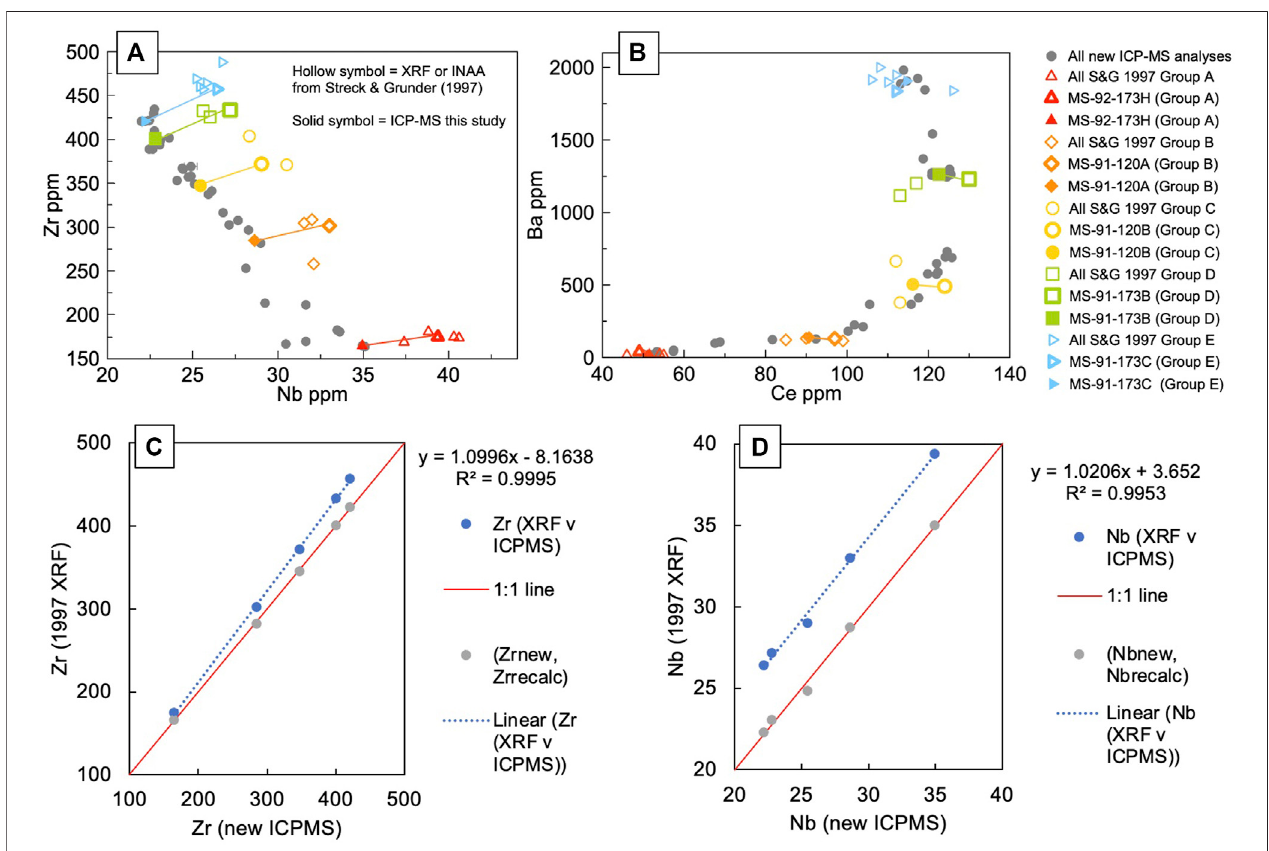
FIGURE 3 | (A,B) Original XRF and INAA data from Streck and Grunder (1997) plotted with new ICP-MS data from this study for comparison. Streck and Grunder (1997) Zr, Nb, Ce, Pb, and Sr XRF and INAA data were recalculated based on their signi fi cant percent difference when compared to new ICP-MS data of fi ve select samplesfromStreckandGrunder(1997)reanalyzedinthisstudy(connectedbytielines).Errorbars(2-sigma)forthenewICP-MSdataaretoosmalltobevisiblebeyond thedatapointfornearlyallanalyses. (C,D) Zrand Ndexamplesoflinearregressionplotscomparingoldandnewdatatodisplay offsetandgenerate arecalculation equation. Blue points use Streck and Grunder (1997) data and new data, and grey points use recalculated Streck and Grunder (1997) data and new data. Recalculated data are used in all analysis after this point. See Supplementary Appendix A for full recalculations and plots.